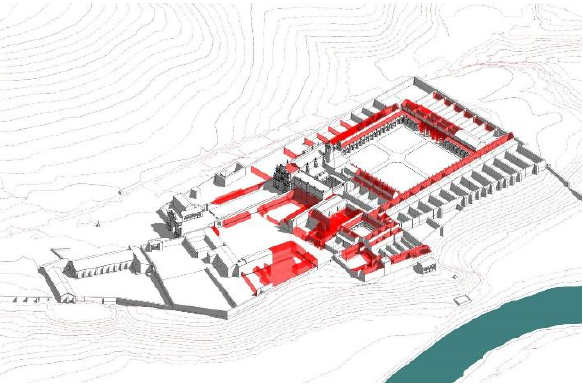
Figure 3: Ruins and demolitions scope after the secularization of the monastery. HBIM Charterhouse of Jerez, phase